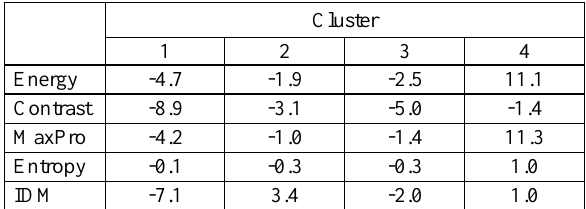
Table 6. Changes between initial and final cluster centers in k-means clustering prediction (%)